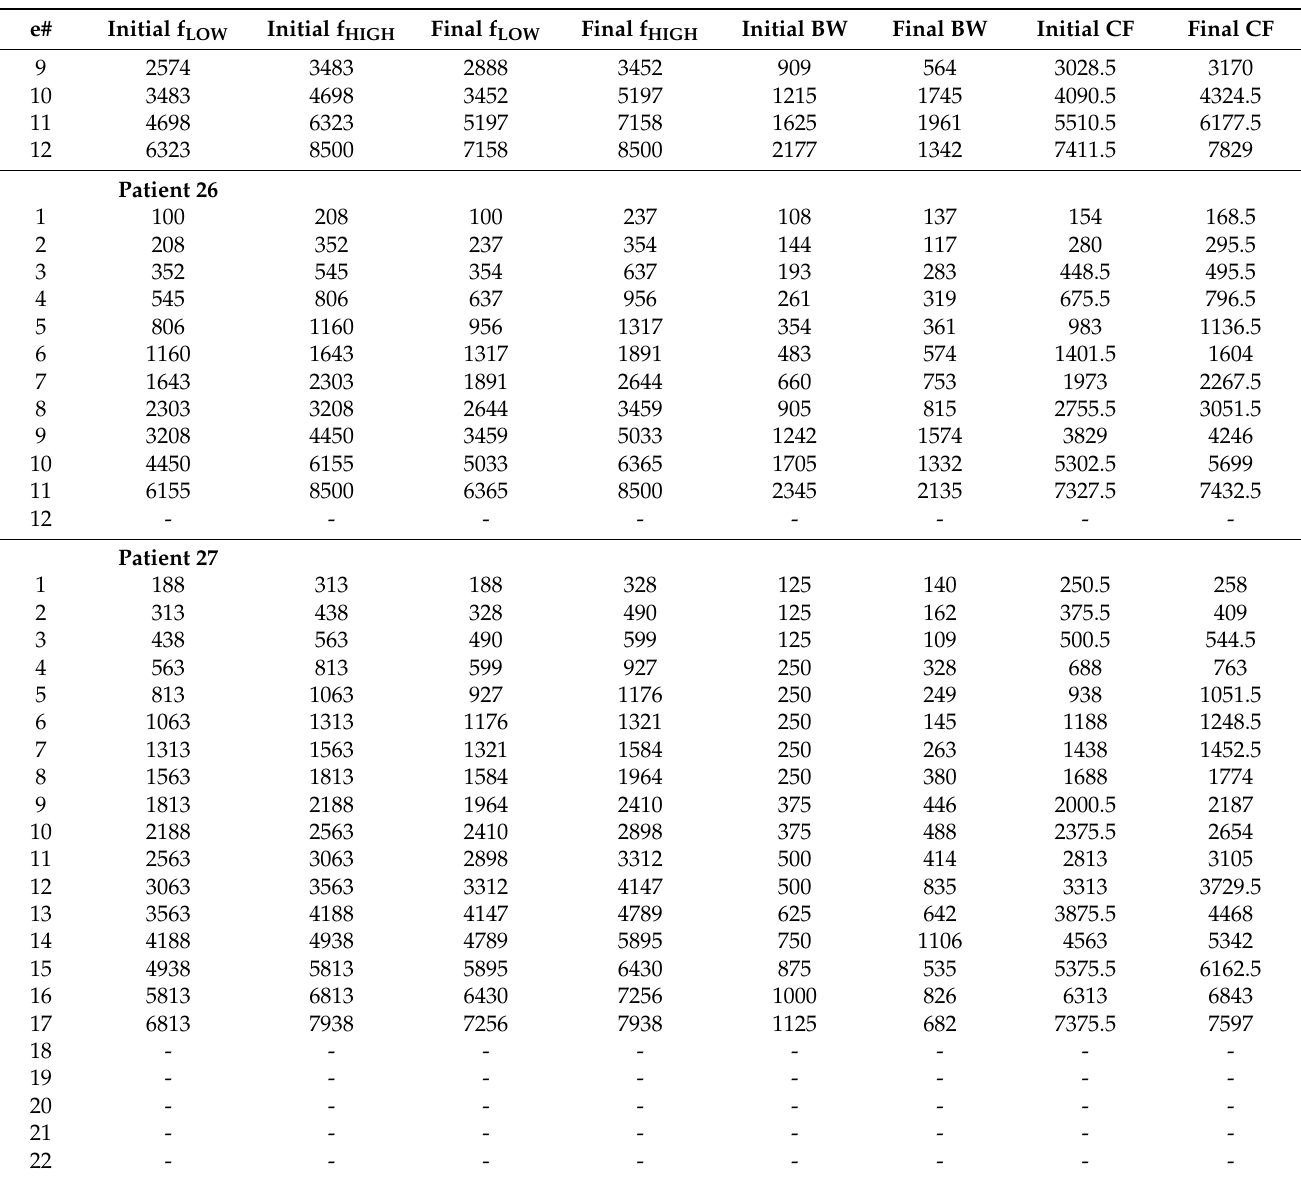
Table A2. The electrode position on post-operative CT scanner, center frequency deduced from the Greenwood map, default central frequency, and central frequency after fitting. BML